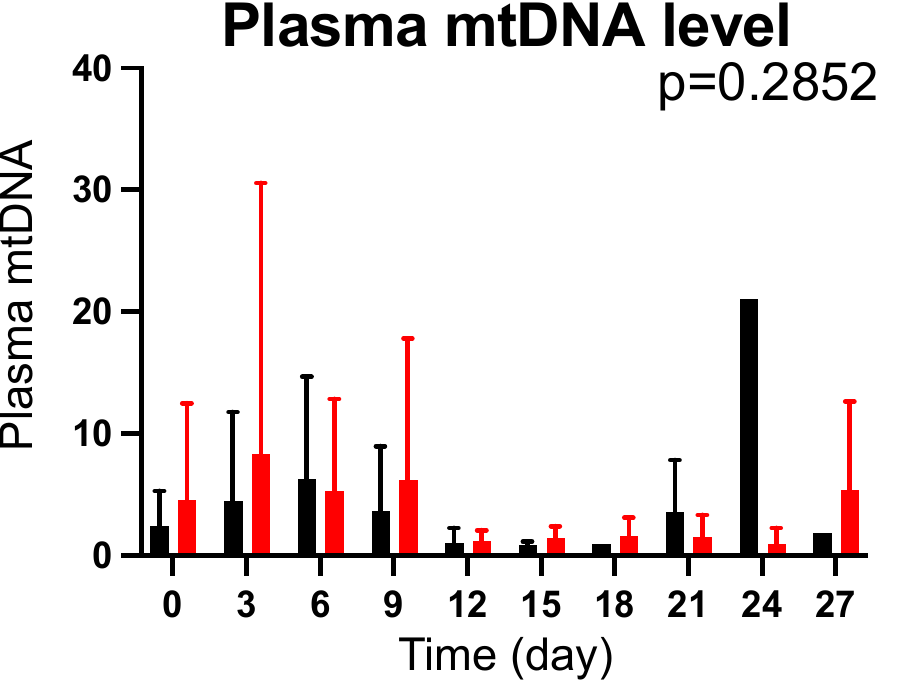
Figure 4. Effects of CoQ10 supplementation on plasma mtDNA levels in burn patients. There was no difference in plasma mtDNA levels between the groups. The p value in the figure indicates overall difference between the groups across the different time points that was analyzed using a longitudinal general linear mixed-effects model. Black bar: Placebo, Red bar: CoQ10.